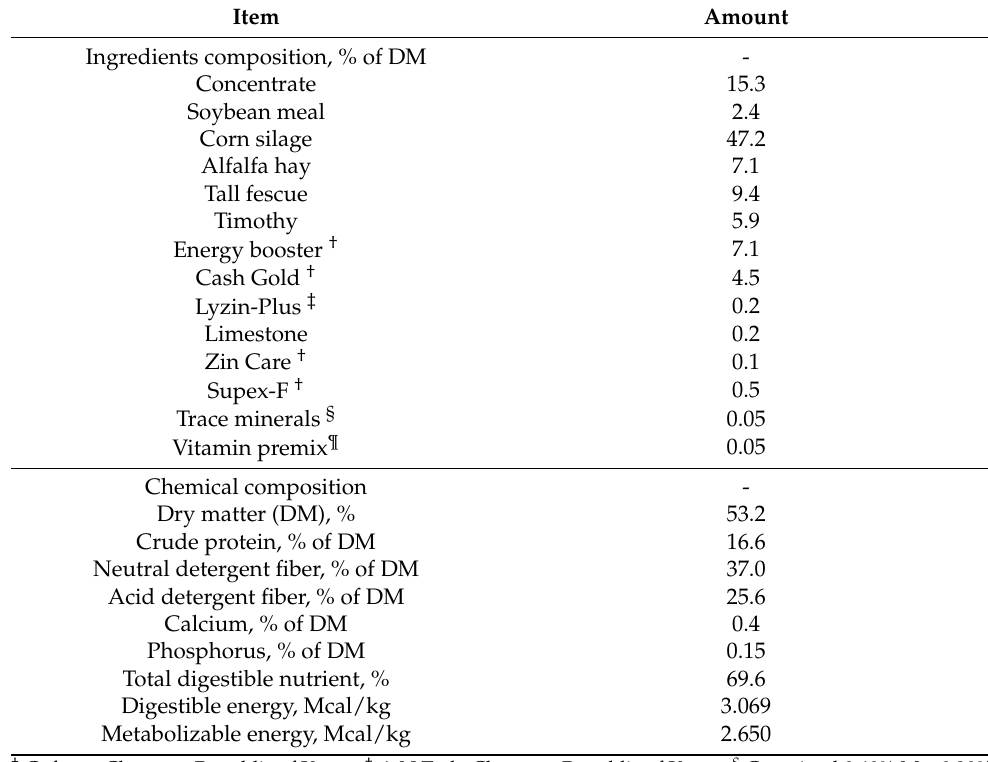
Table 1. Ingredients and nutrients of the experimental diets used in this